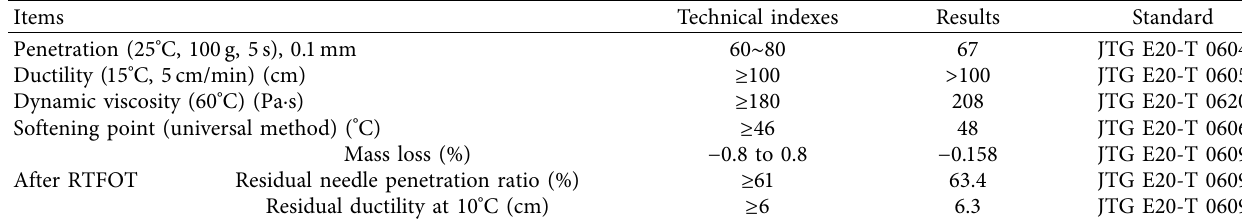
Table 1: Properties of the matrix asphalt.